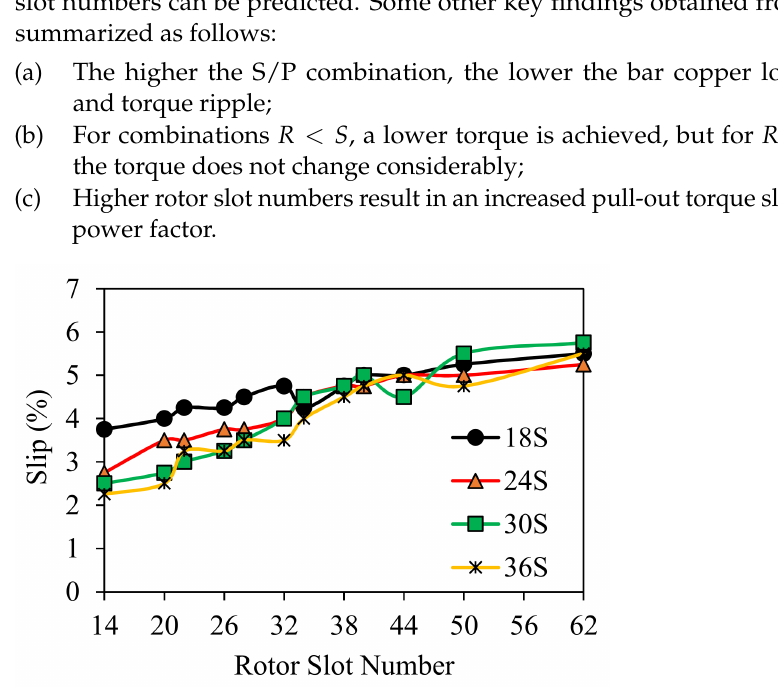
Figure 27. Variation of the pull-out torque slip with a rotor slot number for various S/P